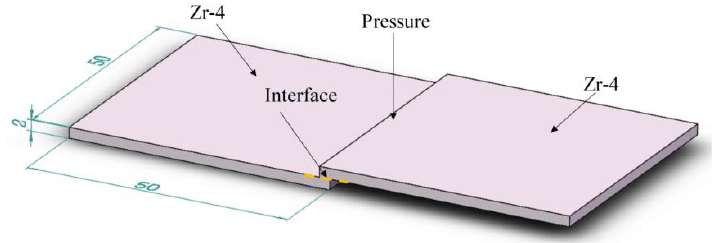
Figure 1. Schematic diagram of the diffusion bonding assembly.